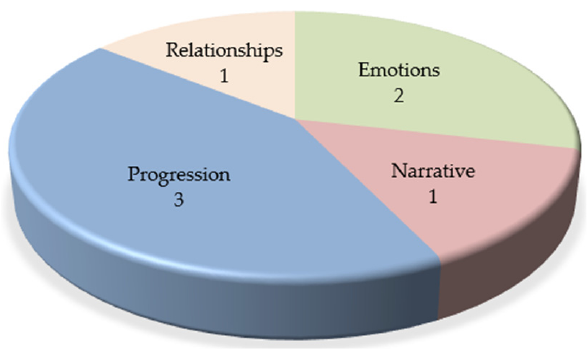
Figure 5. Number of primary studies by game dynamics.